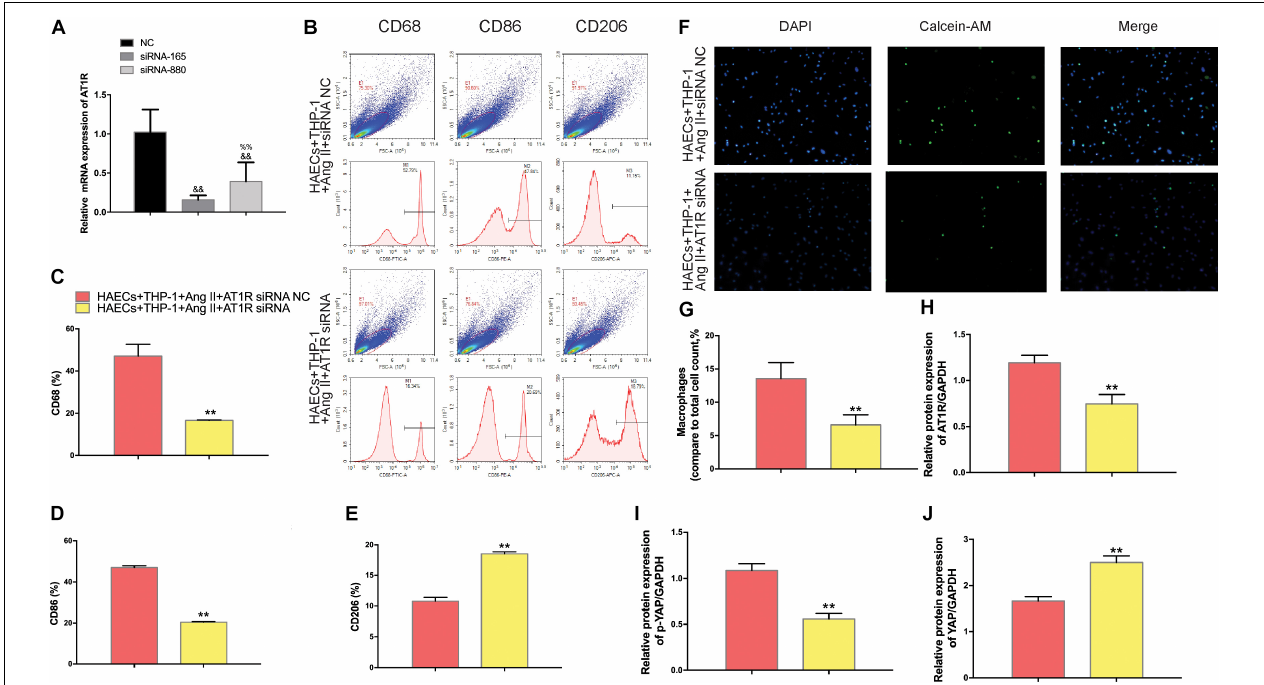
FIGURE 4 | The effect of AT1R siRNA transfection on macrophages was consistent with the effects of telmisartan treatment, further demonstrating that Ang II regulates macrophage polarization and adhesion activity by binding to AT1R. (A) AT1R siRNA knockdown efficiencies ( n = 3, mean and S.D., t -test, && P < 0.05 compared with siRNA NC; %% P < 0.05 compared with siRNA-165); (B) Flow cytometry analysis of CD68, CD86, and CD206 expression after 96 h co-culture in both groups. The data shown in the one-factor histogram for each group represents the cells in the red circle in the upper scatter plot. HAECs + THP-1 + Ang II (1 µ M, 24 h) + siRNA NC group: CD68, 52.79%; CD86, 47.84%; CD206, 11.15%. HAECs + THP-1 + Ang II + AT1R siRNA group: CD68, 16.34%; CD86, 20.69%; CD206, 18.79%; (C–E) The proportion of CD68 +, CD86 +, and CD206 + cells, respectively ( n = 3, mean and S.D., t -test, ** P < 0.05 compared with the HAECs + THP-1 + siRNA NC group); (F) Fluorescence staining of adherent macrophages after AT1R siRNA transfection. All cells were labeled with DAPI (blue), and the number of adherent macrophages decreased significantly with AT1R siRNA transfection; (G) The ratio between the number of macrophages and the total number of cells ( n = 3, mean and S.D., t -test, symbols are the same as in C,D,E ); (H–J) , The ratio between AT1R and GAPDH, p-YAP and YAP, or YAP and GAPDH expression was calculated based on the western blot results shown in Figure 3A ( n = 3, mean and S.D., t -test, symbols are the same as in C–E